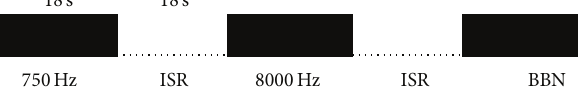
Figure 2: Schematic of block auditory testing paradigm. Partici- pants passively listened to randomly selected pure tones (750 Hz or 8000 Hz) or broadband noise (BBN) for 18sec each, immediately followed or preceded by an interstimulus rest period (ISR) consist- ing of silence/absence of auditory stimulation for 18 sec for a total experiment run time of 20 minutes. Each randomized paradigm was repeated 9 times to prevent potential confounding effects and to optimize average responses under each recording